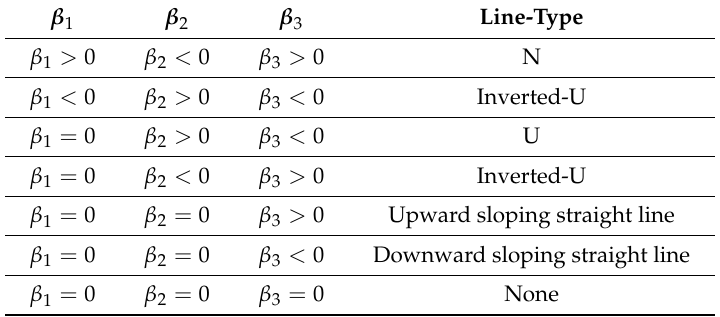
Table 2. The hypothetical results of the panel environmental Kuznets curve (EKC) model. β 1 β